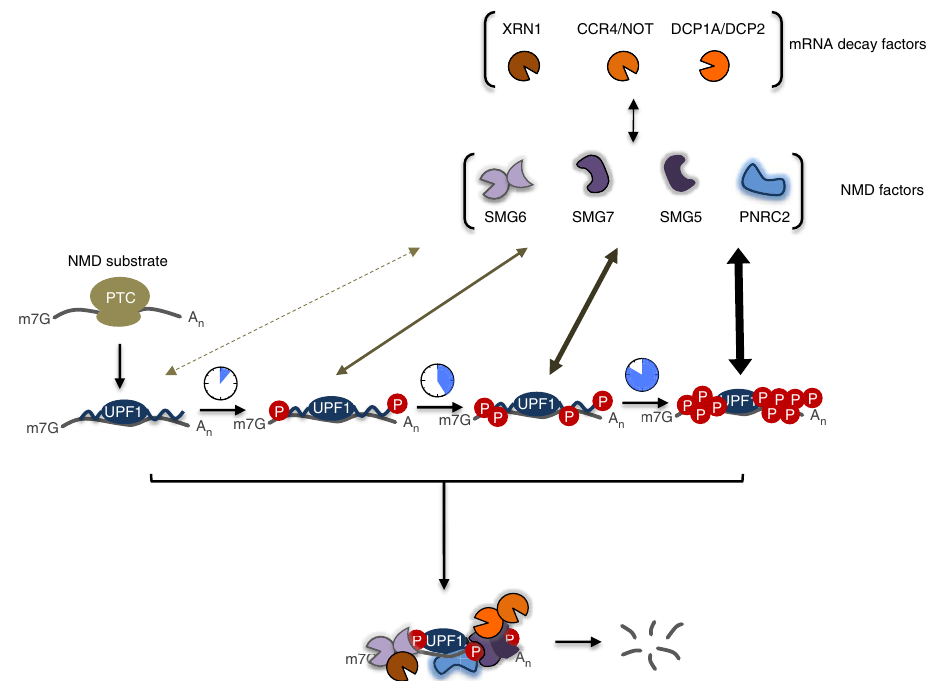
Figure 7 | Model representing the amplification of mRNA decay signal through UPF1 hyperphosphorylation. When downstream decay steps are limiting, UPF1 stalls on NMD-targeted mRNPs and is progressively phosphorylated on [S/T]Q motifs. The increase in phosphorylation progressively promotes the ability of UPF1 to activate mRNA